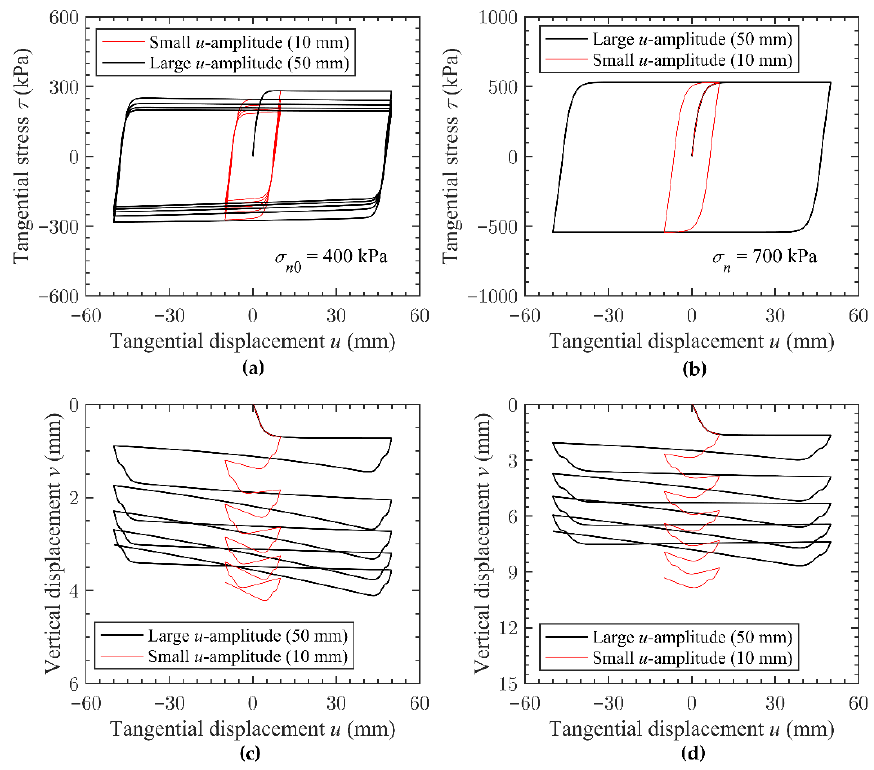
Figure 4. Effect of displacement amplitude on the stress–displacement behaviour of the Zipingpu rockfill–steel interface [11]: ( a ) tangential displacement vs. tangential stress under CNS; ( b ) tangential displacement vs. tangential stress under CNL; ( c ) tangential displacement vs. normal displacement under CNS; ( d ) tangential displacement vs. normal displacement under CNL.